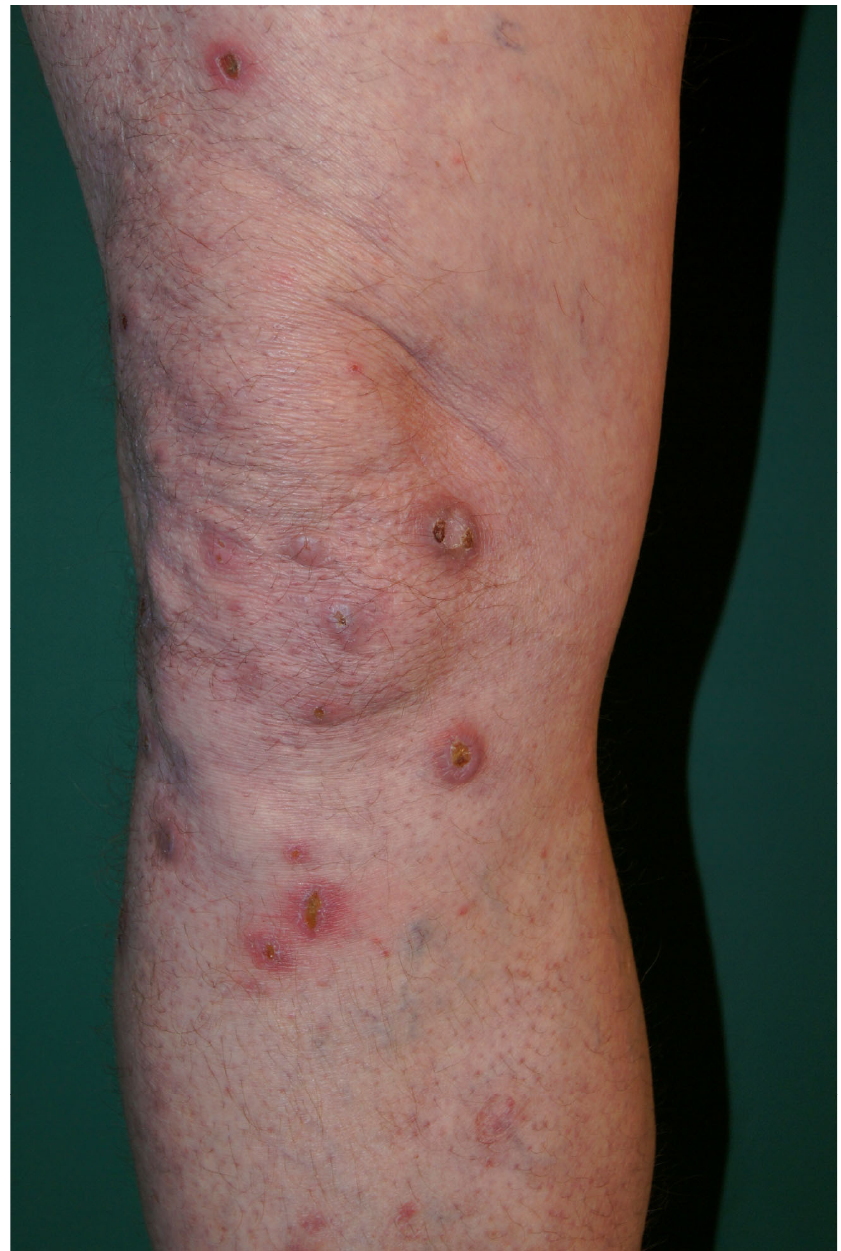
Figure 5. Clinical image of prurigo nodularis lesions.